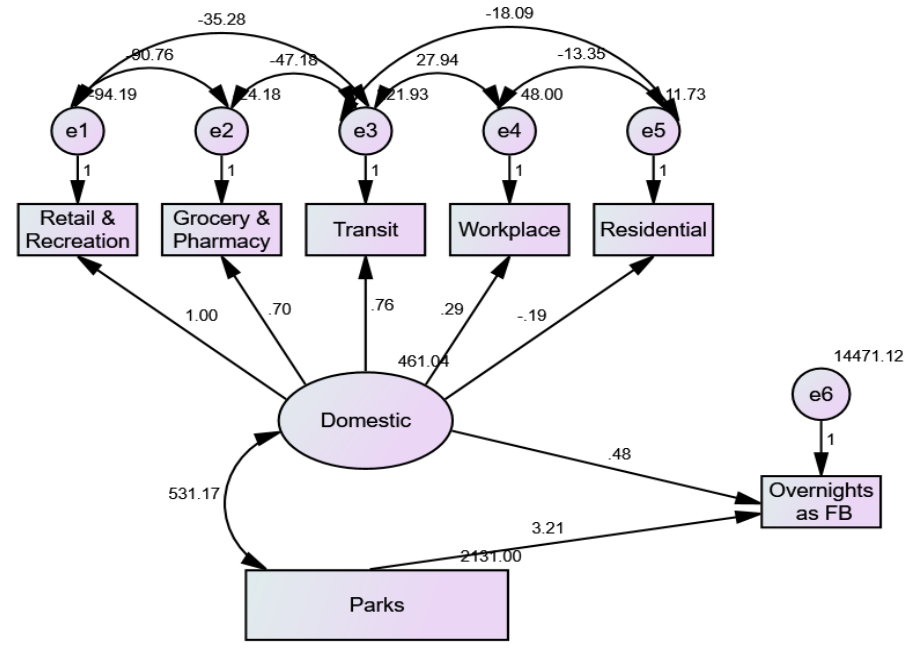
Figure 12. The unstandardized model.